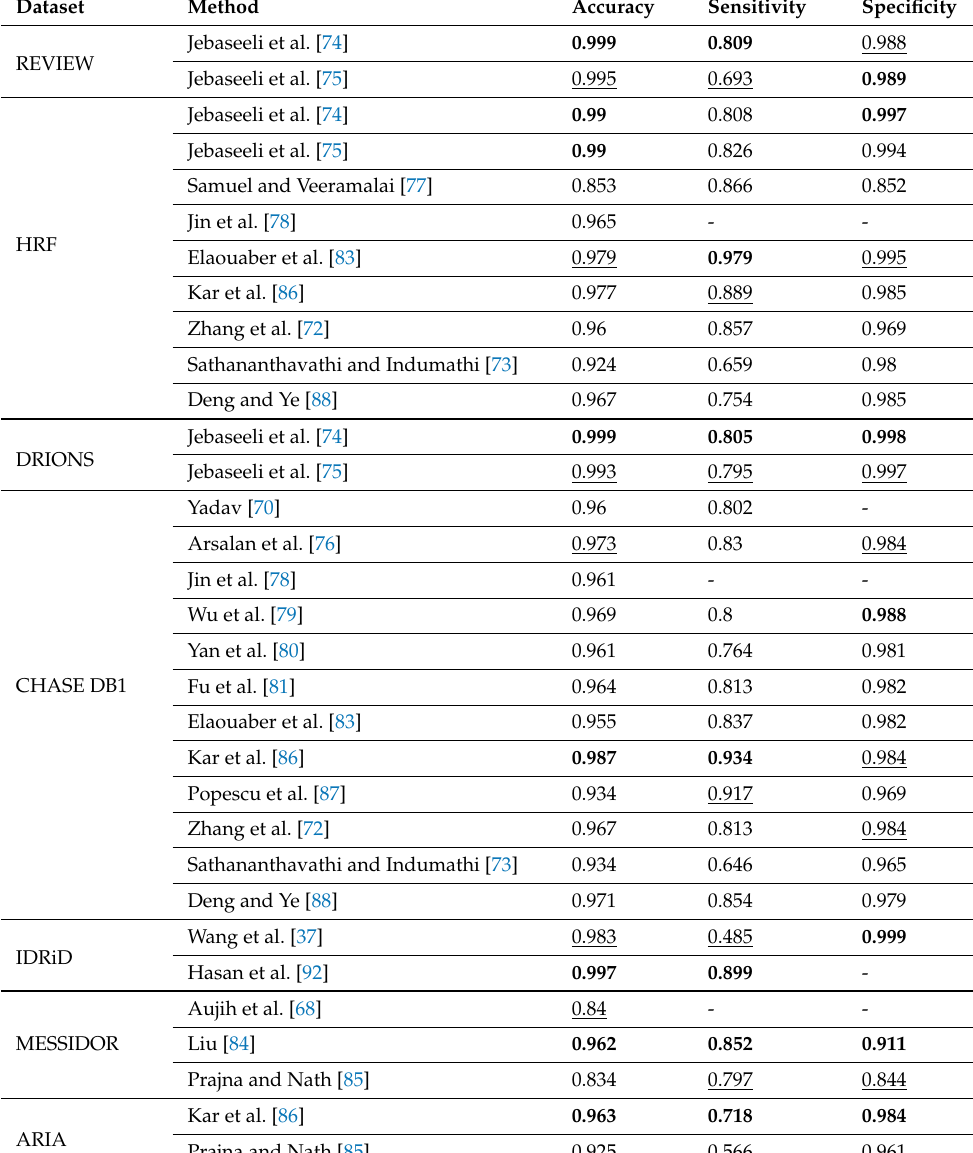
Table 5. Performance comparison of deep-learning based diabetic retinopathy segmentation. The bold and underlined fonts correspondingly show the first and second